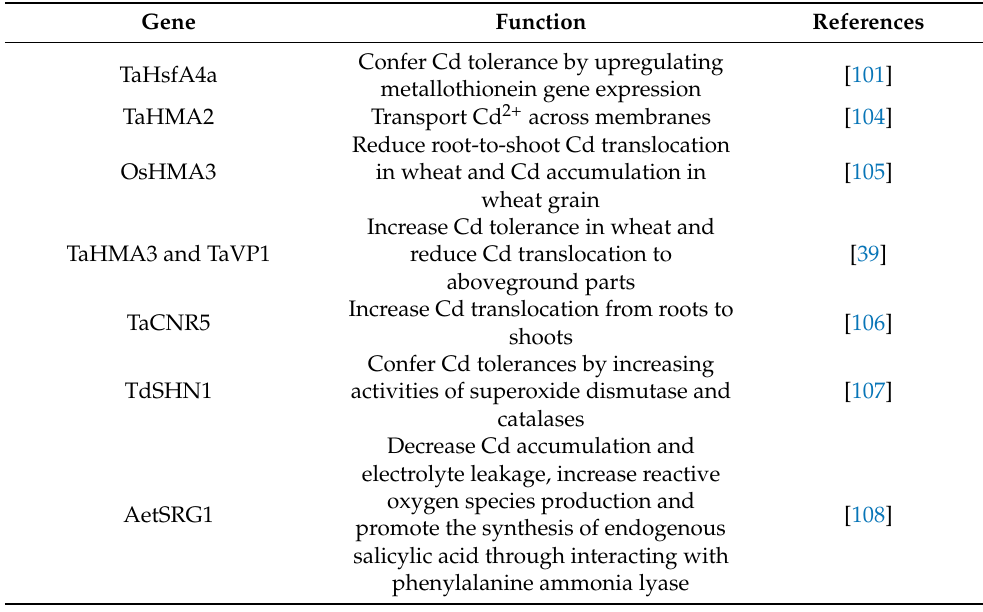
Table 3. Functional genes in wheat under Cd stress.